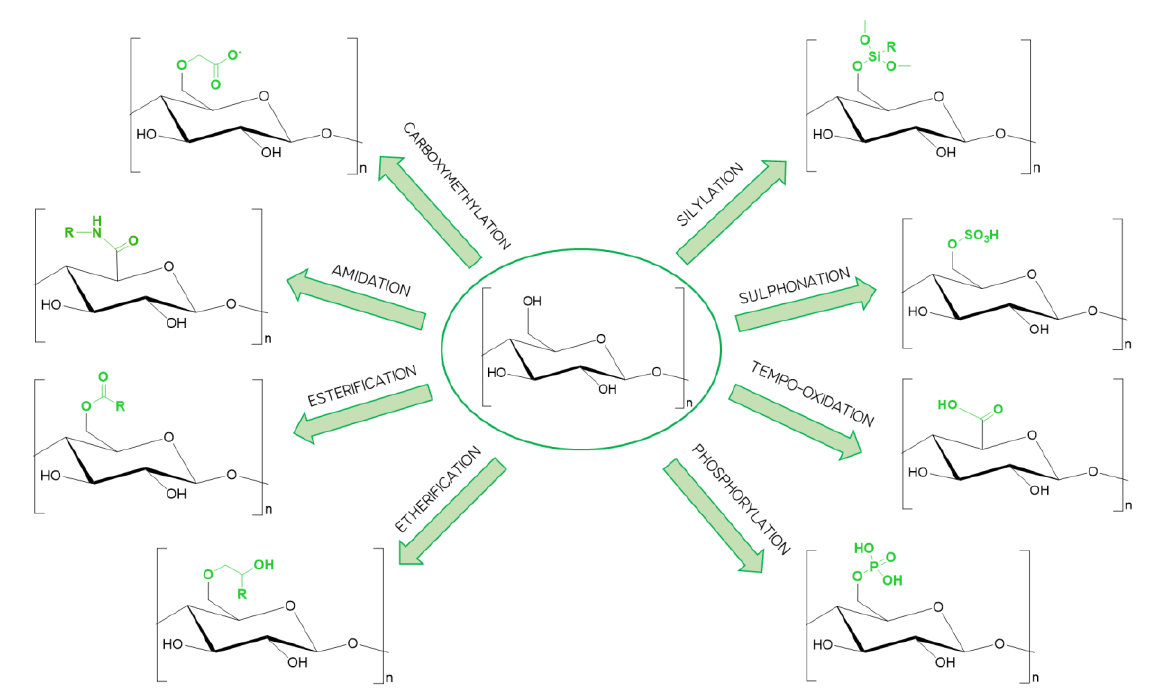
Scheme 1. Different chemical functionalizations of cellulose at the C6